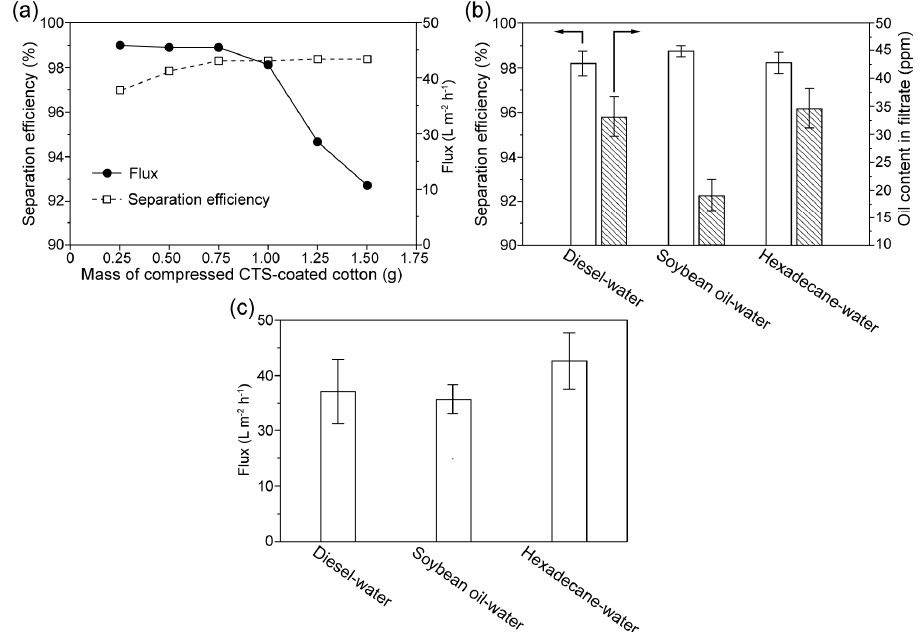
Figure 8. ( a ) The separation efficiency and the corresponding separation flux using CTS-coated cotton with constant compressed density (0.28 g cm − 3 ) and different mass. ( b ) The efficiency in the separation of contaminated oil-in-water emulsions and the oil content in the corresponding filtrate using the optimized compressed CTS-coated cotton. The efficiencies were higher than 98% for separating various kinds of emulsions. ( c ) The fluxes during the separation of diesel-in-water, soybean oil-in-water and hexadecane-in-water emulsions. The flux varies from 30 L m − 2 h − 1 to 48 L m − 2 h − 1 for separating various kinds of emulsions.